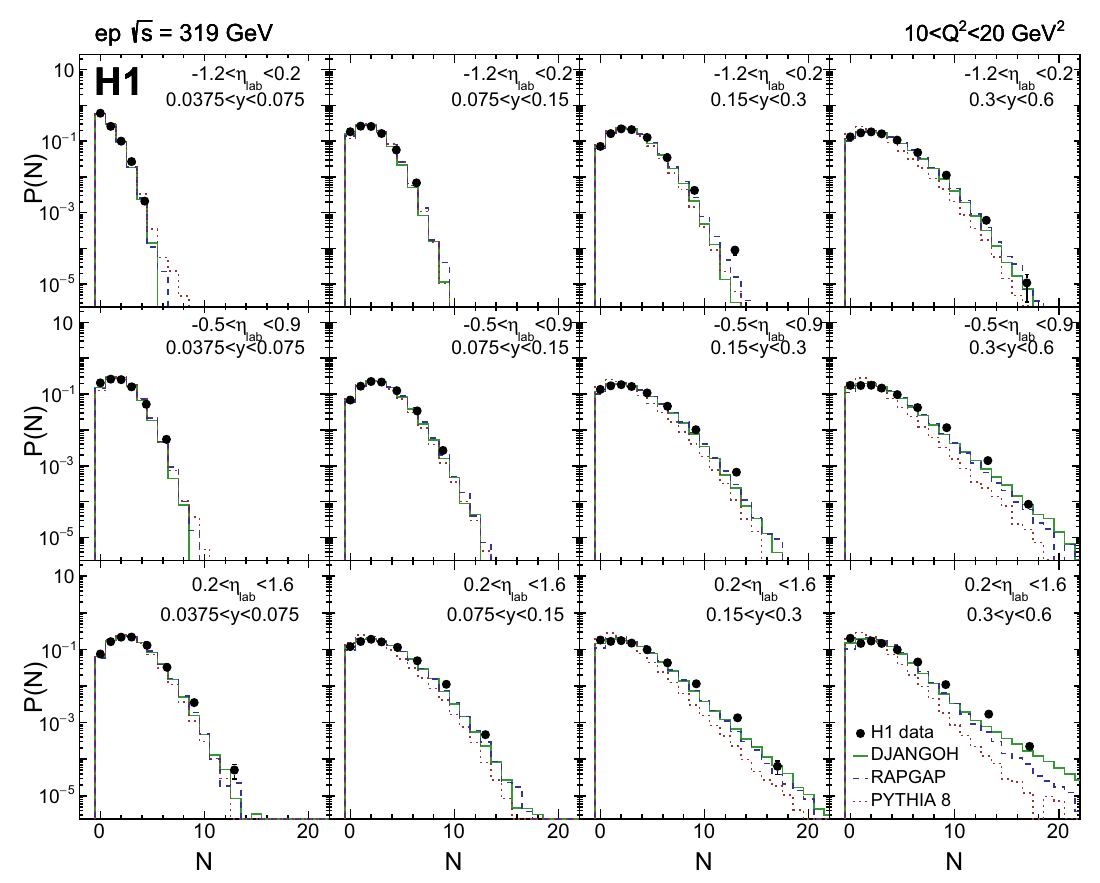
Fig. 4 Charged particle multiplicity distributions P ( N ) as a function indicated by the text in the figure. Predictions from DJANGOH, RAP- √ s = 319GeV ep collisions in the of the number of particles N at GAP and PYTHIA 8 are also shown. The total uncertainty is denoted range 10 < Q 2 < 20 GeV 2 . Further phase space restrictions are given by the error in Table 1. Different panels correspond to different η and y bins, as lab